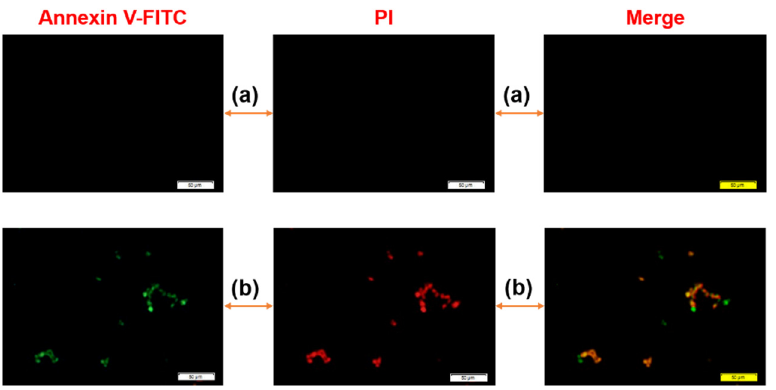
Figure 7. Fluorescent microscopic images of Annexin V-FITC/PI on 4T1 cells with ( a ) control and ( b ) PA-AgNPs.